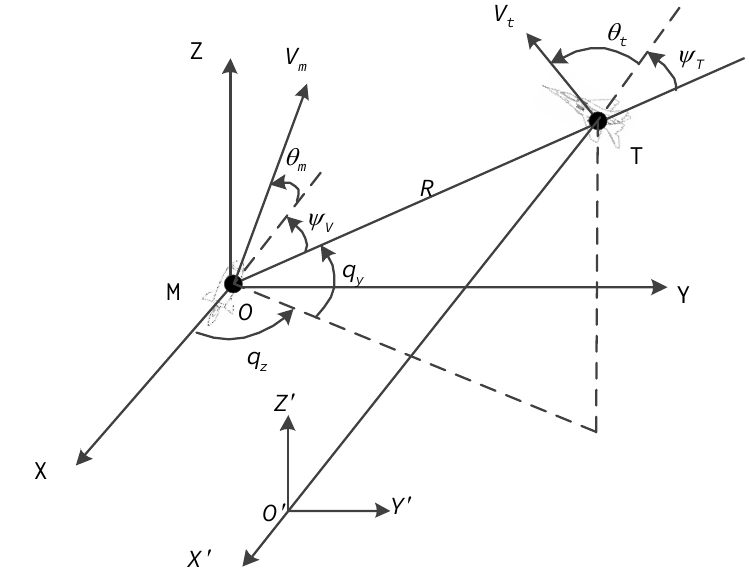
Figure 1. Schematic of the interception space of missile.